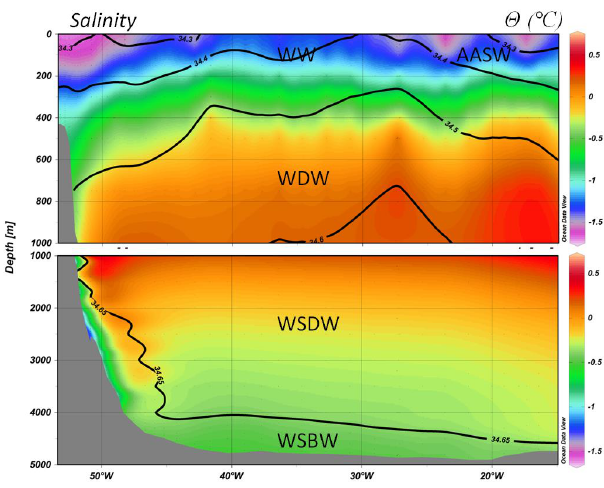
Fig. 2a. Potential temperature (color) and salinity (black contour lines) full depth section of the Weddell Sea transect. Approximate location of water masses is